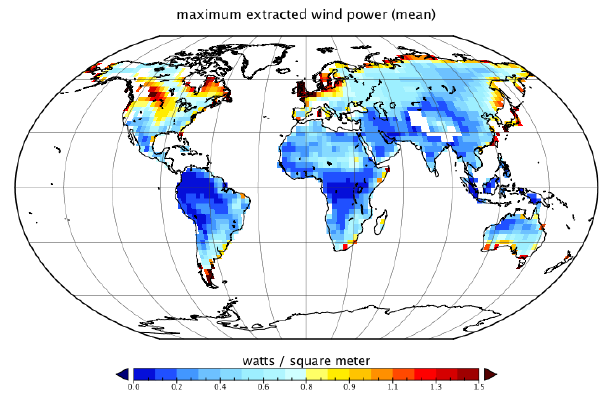
Fig. 8. The maximum wind power extraction at T42 resolution and 10 vertical levels for a total extraction of 34TW of mechanical power. Each non-glaciated land grid point has been parameterized with an additional drag coefficient ( C ext =0.01). Note the influence of the large-scale circulation on large-scale extractable wind power, also noted in Barrie and Kirk-Davidoff (2009).